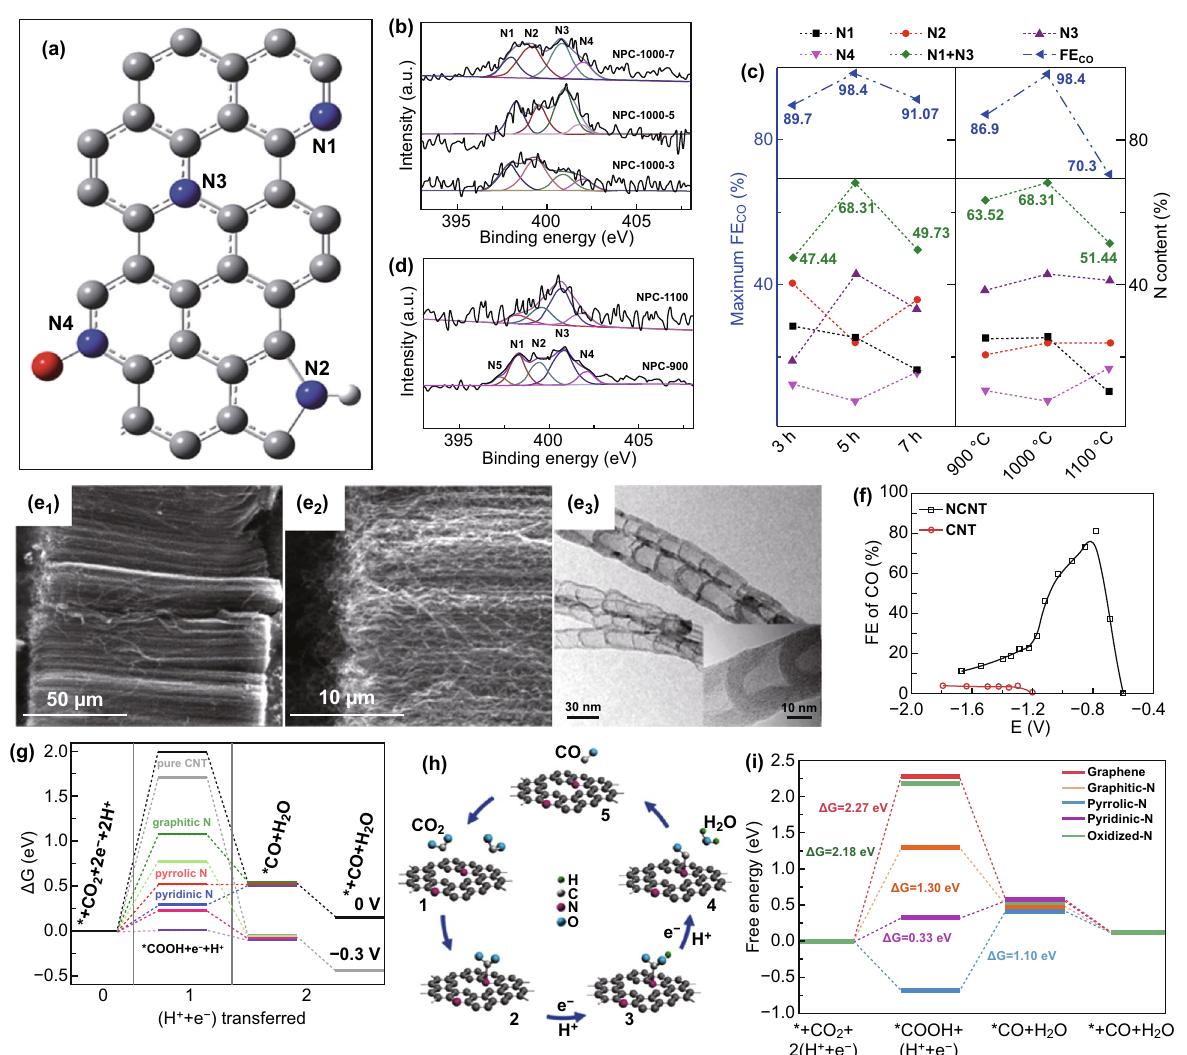
Fig. 4 Heteroatom doping in carbon materials. a Schematic illustration of the structure of different N species in N-graphene sheet [105]. Copy- right © 2012, the Royal Society of Chemistry. b N 1 s XPS spectra of NPC-1000-t. c Atomic contents of each N moiety, N1 + N3 and maxi- mum FECO of NPC. d N 1 s XPS spectra of NPC synthesized at 900 and 1000 °C [106]. Copyright © 2020, John Wiley & Sons, Inc. e1 , e2 SEM images of NCNTs, e3 TEM images of NCNTs (inset shows a single multiwall NCNT). g Free energy diagram for ECR–CO on CNTs and NCNTs [107]. Copyright © 2015, American Chemical Society. h Illustration of the ECR processes on N-GRW catalysts. i Free energy diagram of ECR on various N-GRW catalysts [66]. Copyright © 2018, John Wiley & Sons,